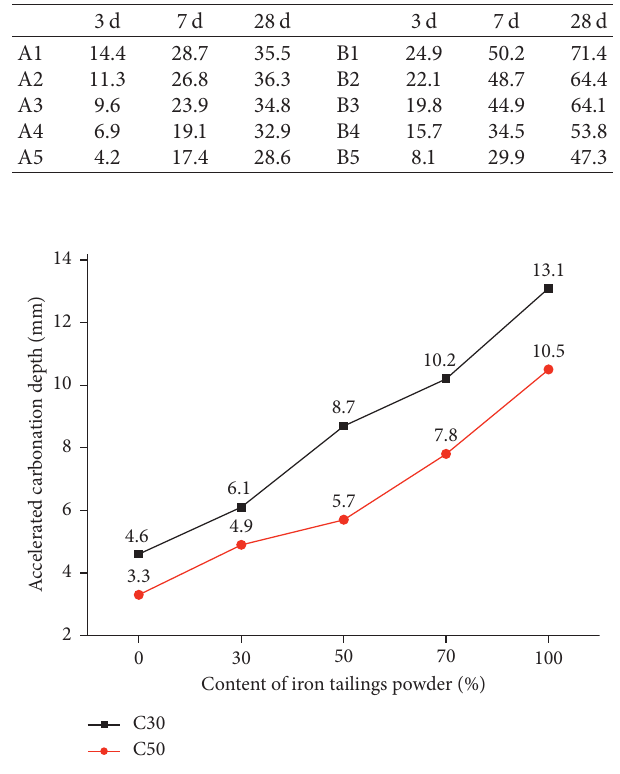
Figure 2: 28 d accelerated carbonization depth of